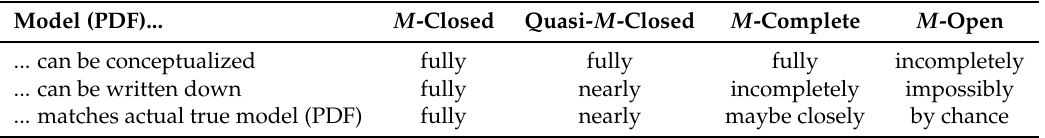
Table 1. Qualitative summary of the four M -settings: M -closed, Quasi- M -closed, M -complete and M -open with respect to the true model. Model (PDF)... M -Closed Quasi- M -Closed M -Complete M -Open ... can be conceptualized fully fully fully incompletely ... can be written down fully